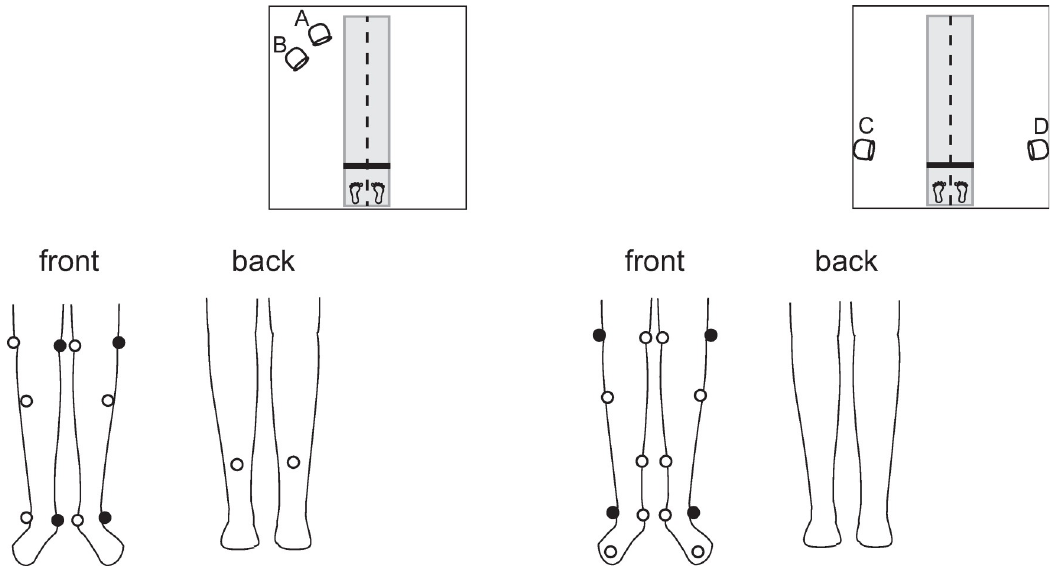
Fig 2. Reflective marker placement. A rigid body model was made for the shank segment from six infrared reflective markers. During the recording obstacle-crossing behavior, the markers on the side of the knee and ankle facing the Kinect were removed to minimize the interference between the Azure Kinect and the optical motion